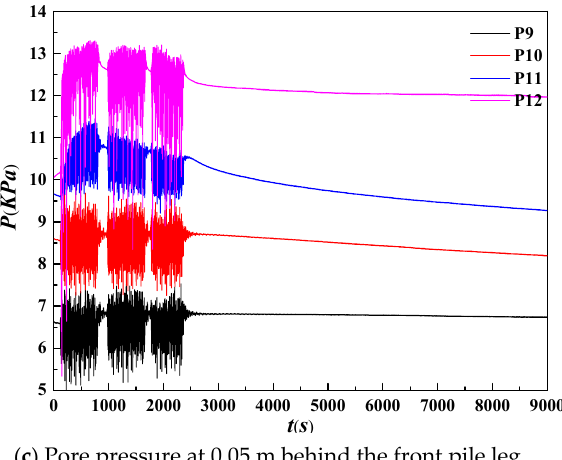
( c ) Pore pressure at 0.05 m behind the front pile leg. Figure 10. Pore pressure history of the pile leg under waves ( H (cid:2933) = 62.5 cm, H (cid:2929) = 30.0 cm, T = 2.45 Figure 10. Pore pressure history of the pile leg under waves (H w = 62.5 cm, H s = 30.0 cm, T = 2.45 s). s).